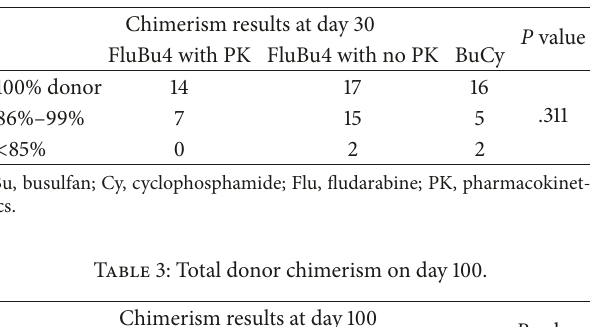
Table 2: Total donor chimerism on day 30.